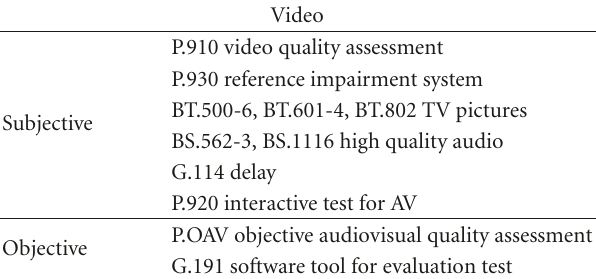
Table 1: Video ITU